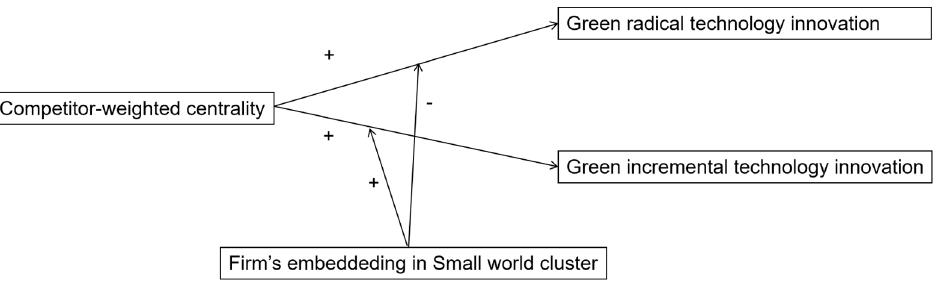
Figure 3. Research framework. “+” indicates the positive effect; “-“ indicates the negative effect.